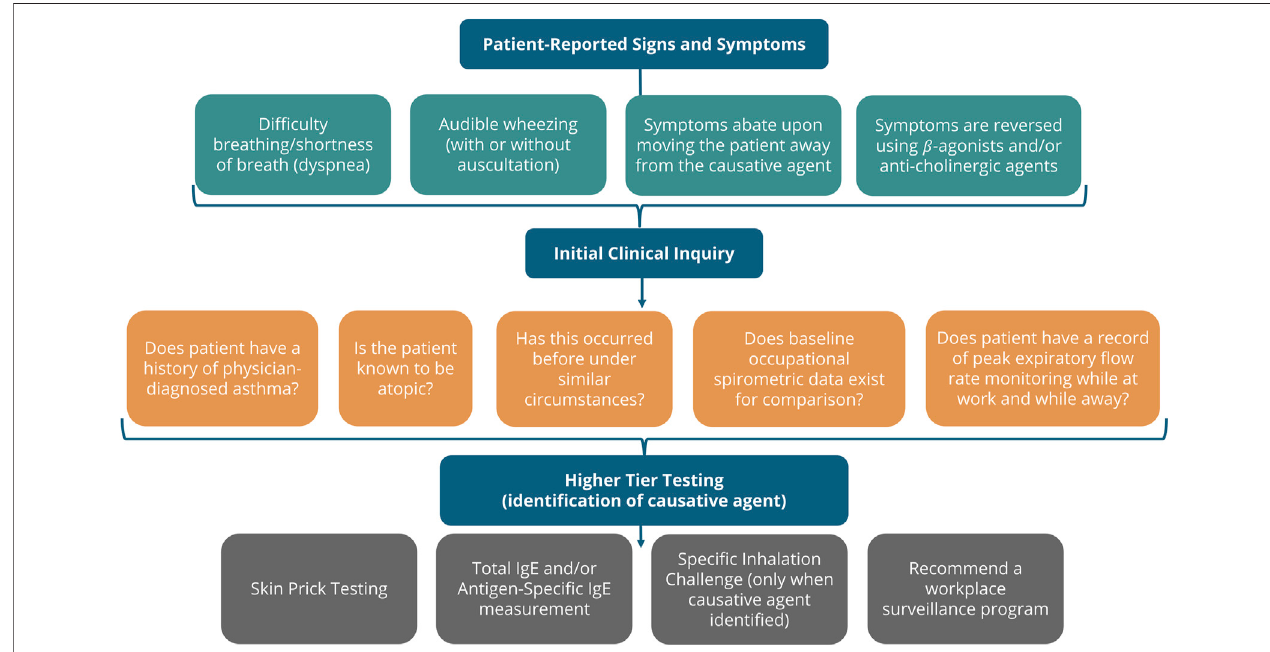
FIGURE 1 | Clinical diagnosis of Allergic Asthma. The clinical inquiry following presentation of a patient suspected of chemical allergy is shown. If the symptoms occurfollowingexposureintheworkplace,theclinicianmaypursuetheidenti fi cationofanymaterialsintheworkplacesuspectedtobecausative.Ifenoughevidencecan be collected, higher tier testing demonstrating an immune-mediated respiratory response is consistent with respiratory sensitization (Friedman-Jiménez et al., 2000; Beckett, 2008; Malo et al.,